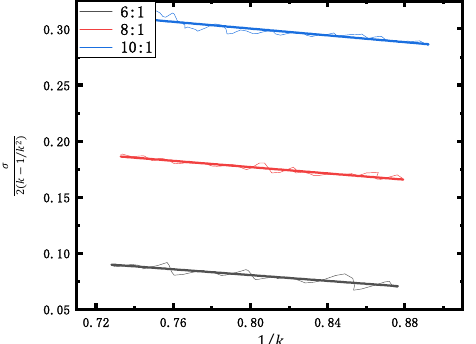
Figure 4. Relationship between tensile ratio and stress.